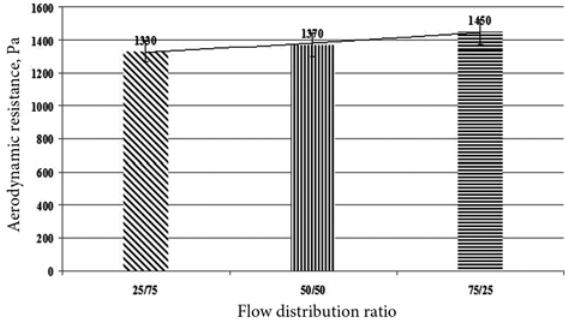
Fig. 9. Relationships between aerodynamic resistance and airflow distribution ratio in one-level 8-channel cyclone when quarter-rings with 5° opening angle of plates in holes are